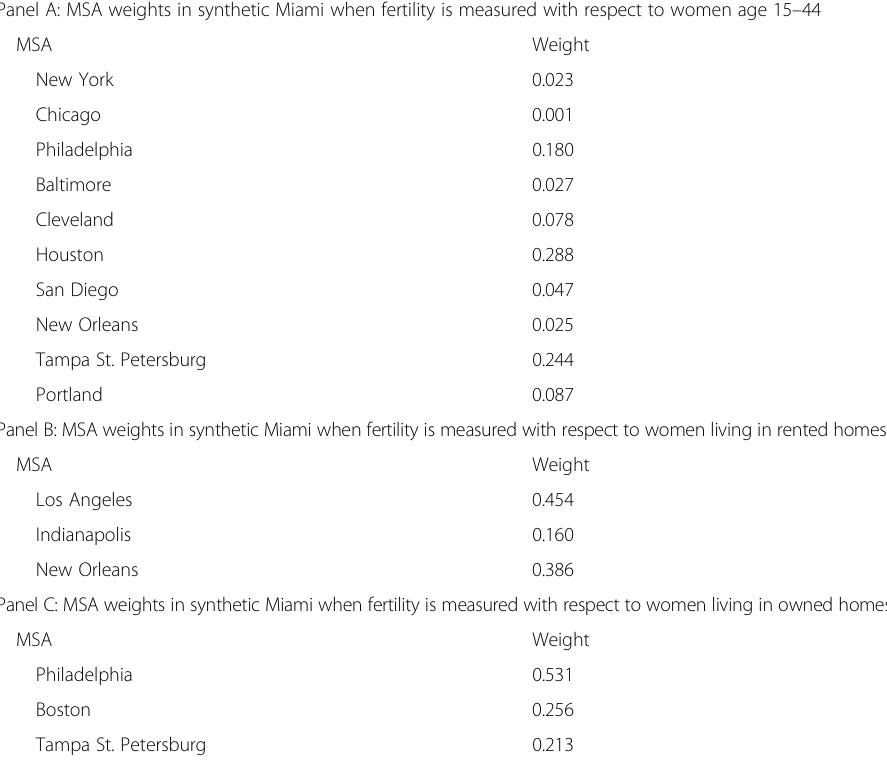
Panel A: MSA weights in synthetic Miami when fertility is measured with respect to women age 15 – 44 MSA Weight